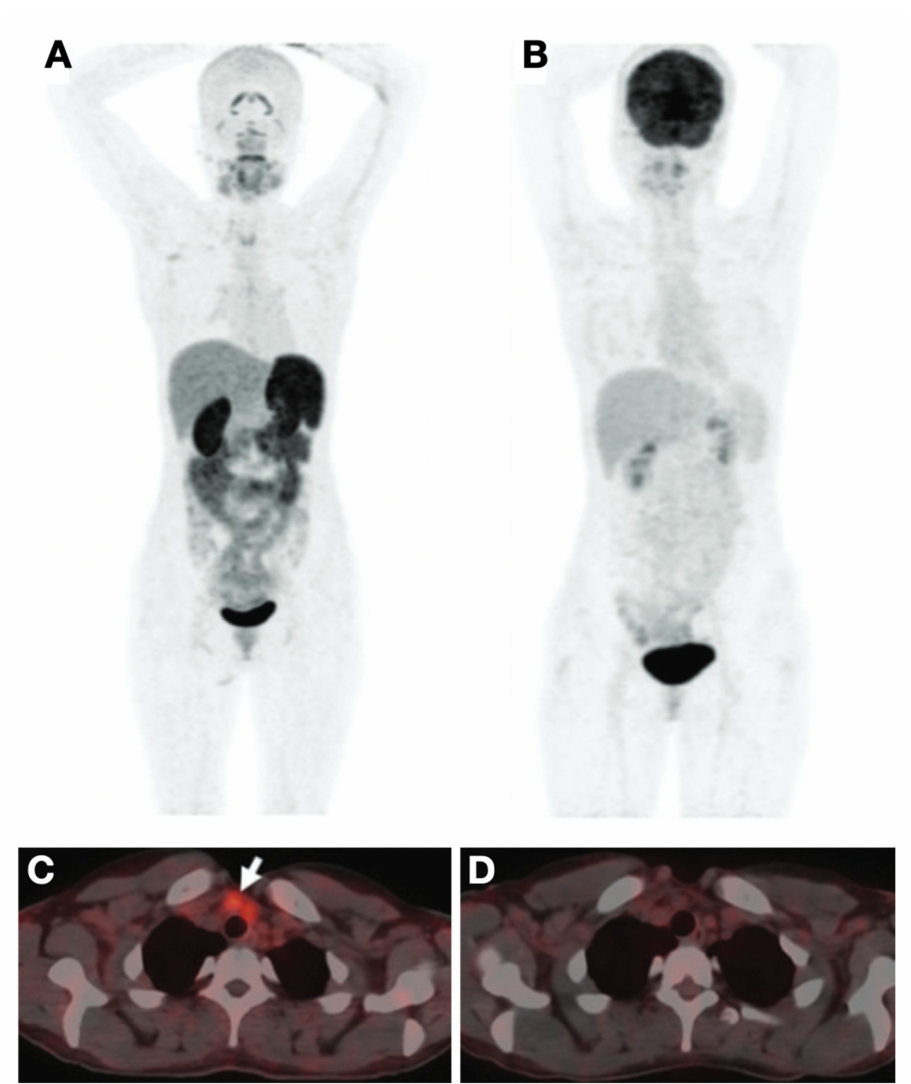
Figure 5. PET/CT imaging comparing [ 68 Ga]Ga-DOTA-RGD2 and [ 18 F]FDG. The RR-DTC case showed a high level of stimulated Tg (85 ng/mL) and negative 131 I post-therapy whole-body scan. Histopathology confirmed the metastatic lesions. ( A ) A maximum intensity projection (MIP) image showed [ 68 Ga]Ga-DOTA-RGD2 positive foci in the lower cervical region. ( B ) The corresponding MIP image of [ 18 F]FDG. ( C ) Fused PET/CT showed the metastatic foci was [ 68 Ga]Ga-DOTA-RGD2 positive; ( D ) the corresponding foci is negative on [ 18 F]FDG fused PET/CT. Reproduced with permission from [85], copyright 2020 Mary Ann Liebert